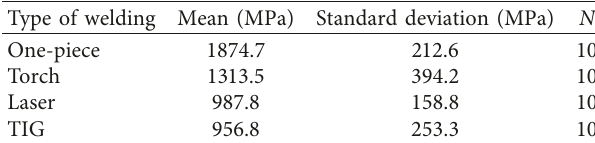
Table 2: Mean and standard deviation of the flexural resistance (MPa) associated with different types of